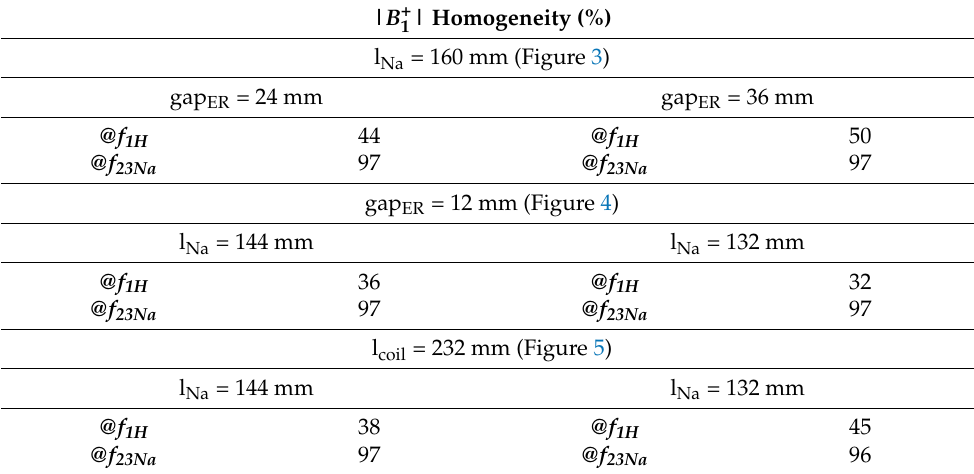
Table 1. | 𝑩 𝟏+ | field homogeneity calculated on the transverse plane (z = 0) using Equation (2). | 𝑩 𝟏+ | Homogeneity (%) l Na = 160 mm (Figure 3) gap ER = 24 mm gap ER = 36 mm